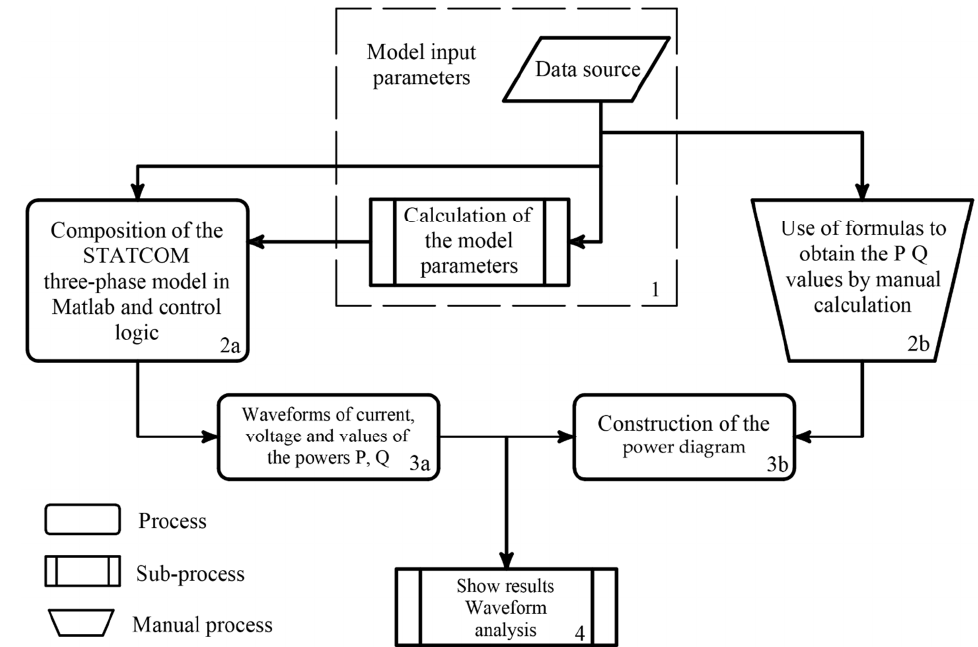
Figure 2. Method